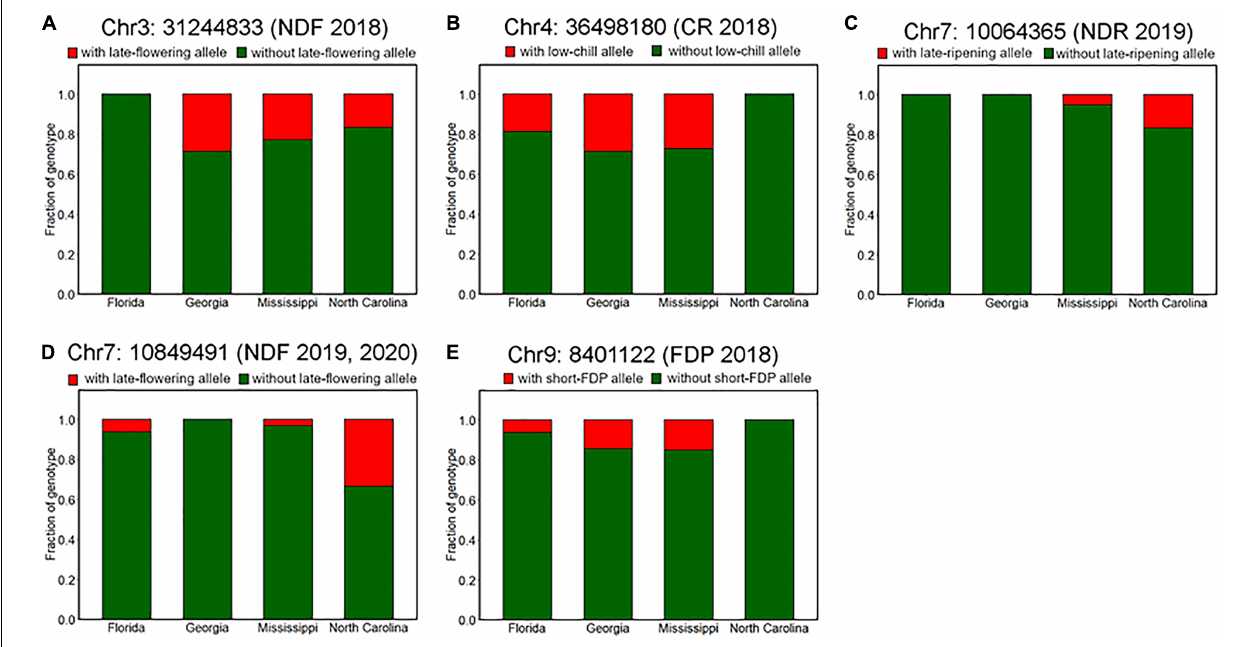
FIGURE 9 | Difference of allele frequencies at the phenology-associated loci among breeding locations. Proportions of genotypes at loci significantly associated with (A) flowering date in 2018 (Chr3: 31244833), (B) CR in 2018–2019 season (Chr4: 36498180), (C) ripening date in 2019 (Chr7: 10064365), (D) flowering date in 2019 and 2020 (Chr7: 10849491), and (E) FDP in 2018 (Chr9: